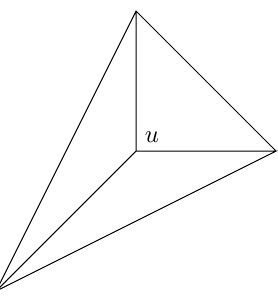
Figure 6: The toric diagram of the local (cid:80) 2